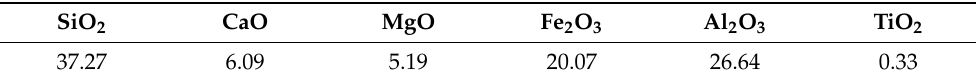
Figure 1. XRD patterns of phosphate ore. Table 2. Chemical compositions of coke ash (mass fraction, wt